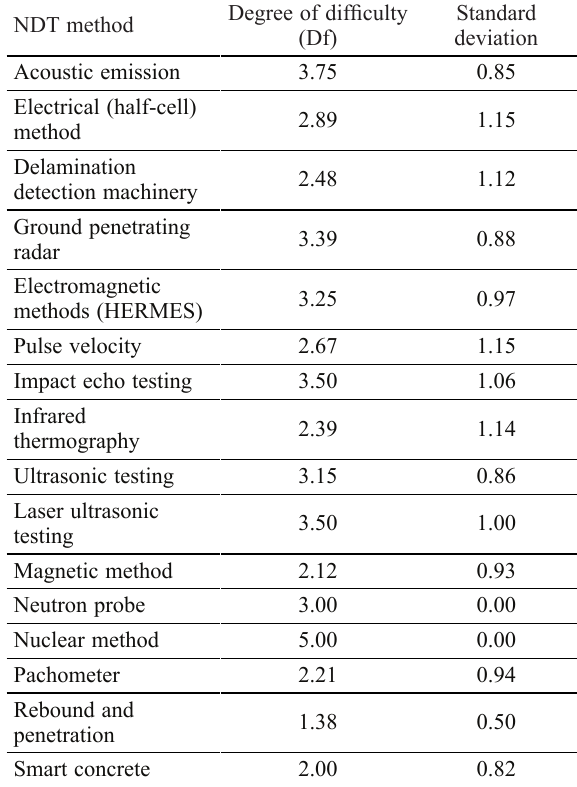
Table 7. Concrete NDT methods: difficulty score